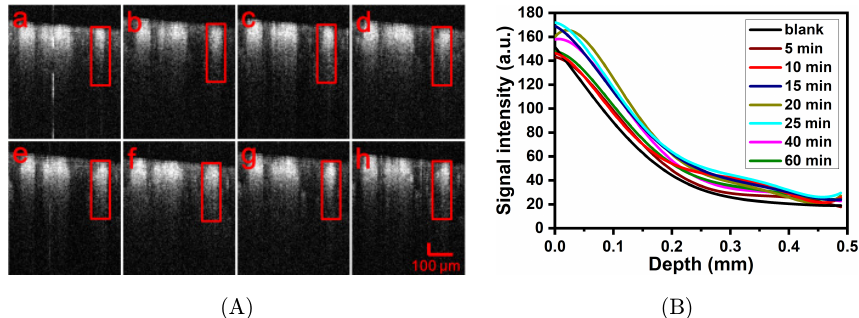
Fig. 6. (A) 2D OCT images of cerebral blood vessels in mice in the absence (a) and presence of PEG-GNRs (1 nM) at various time points, i.e., (b) 5, (c) 10, (d) 15, (e) 20 (f) 25, (g) 40, and (h) 60 min; (B) Fitted attenuation curves of the OCT signal. (The ROIs marked by red solid rectangles indicate cross-sections of blood vessels).